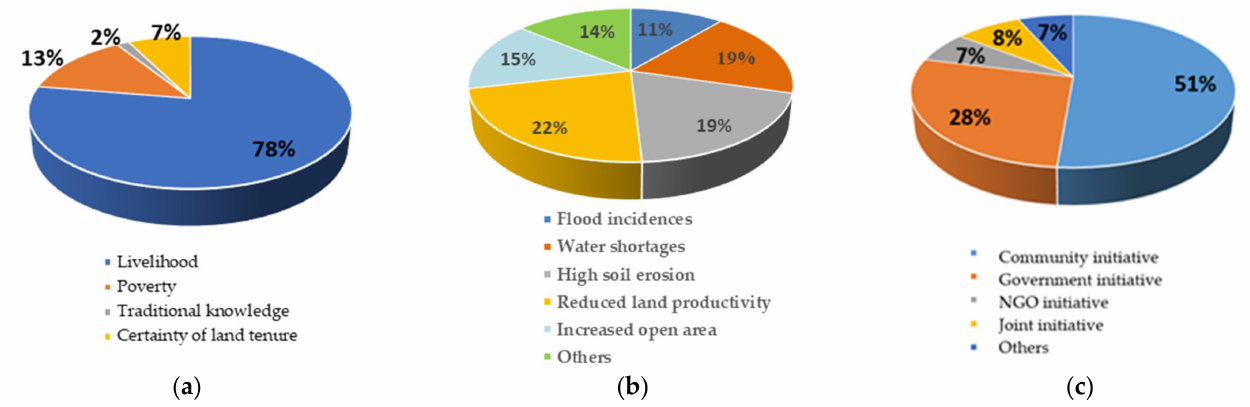
Figure 3. Factors driving communities to develop the agroforestry system in WAR GFP: ( a ) social- economic-cultural aspect, ( b ) ecological aspect, and ( c ) stakeholder initiative